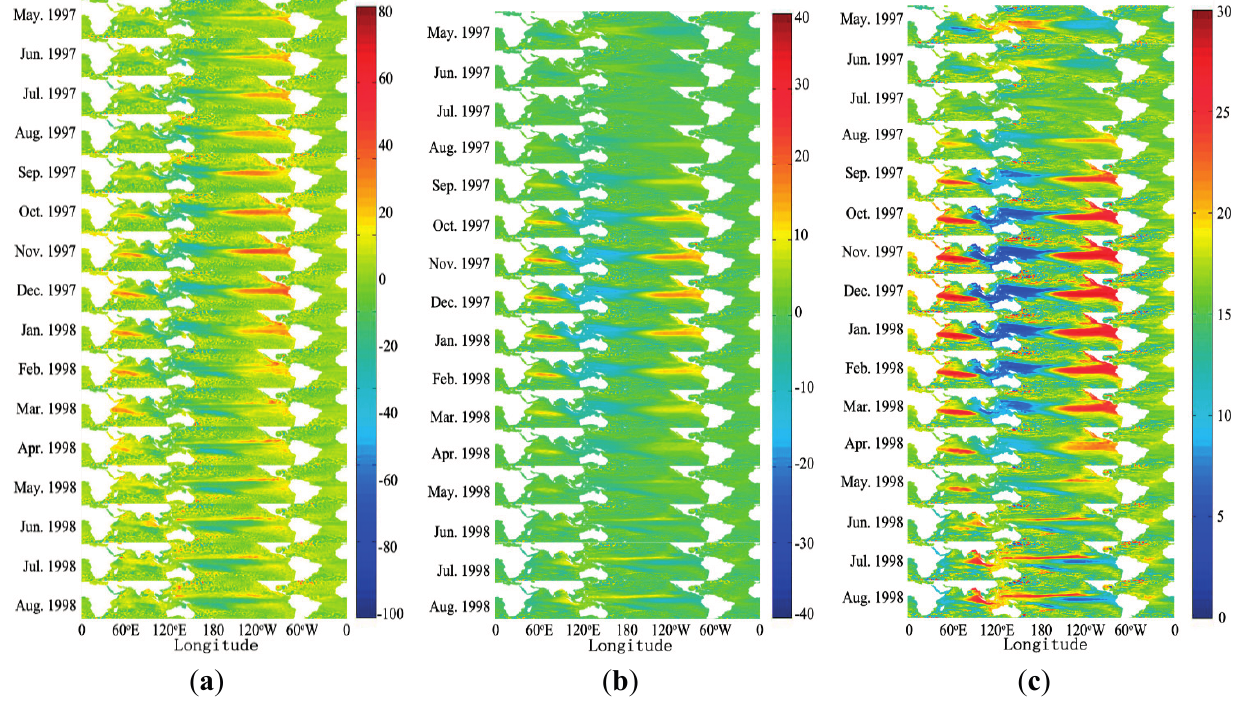
Figure 10. The spatio-temporal evolution of the D4 component during the 1997–1998 El Niño: ( a ) the original data; ( b ) the D4 components; and ( c ) the cluster of D4